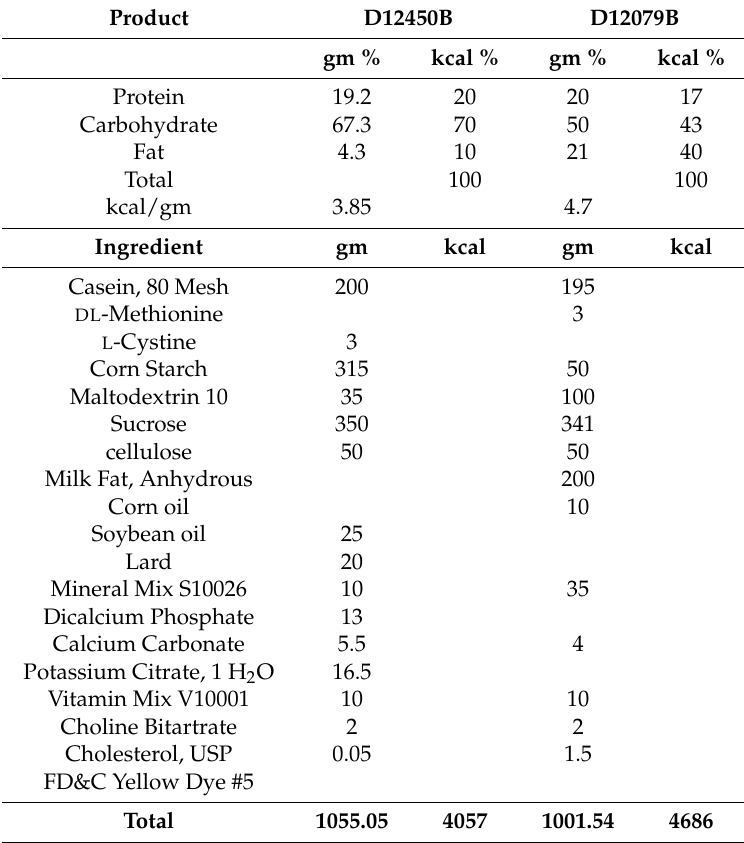
Table 2. Diagrams of concerning composition in regular diets (RD) and Western diets (WTD) for experimental